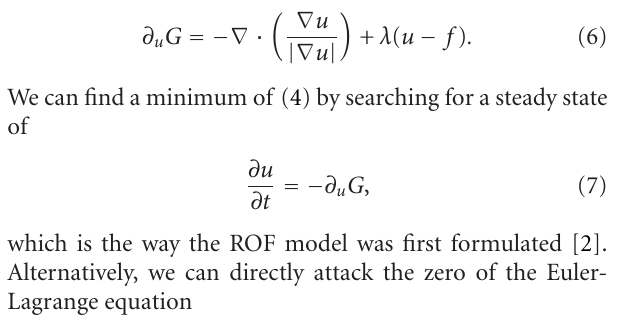
Figure 1: The di ff usion matrix D can be represented by a di ff u- sion ellipsoid, where the semiaxes are spanned by the eigenvectors { V } 3 of D , and the length of each semiaxis is given by the eigen- i i = 1 . In this illustration, the di ff usion is anisotropic. The values { λ i } 3 i = 1 principal di ff usion direction is along eigenvector V 1